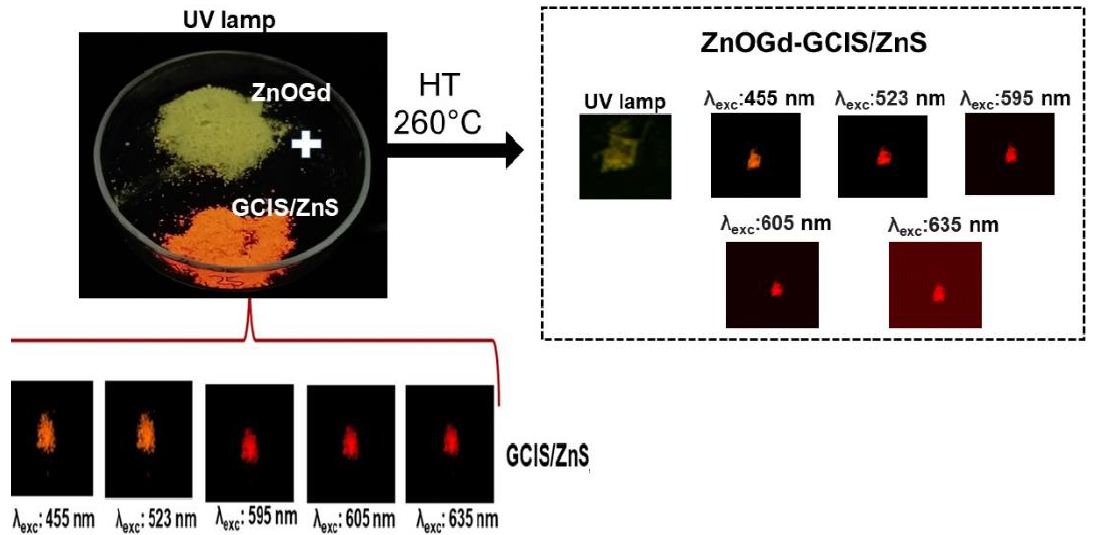
Figure 2. Emissions of ZnOGd under ultraviolet (UV) lamp at 254 nm and emissions of GCIS/ZnS and conjugated Qdots ZnOGd-GCIS/ZnS (75% of ZnOGd and 25% of GCIS/ZnS) using different wavelengths of excitation.